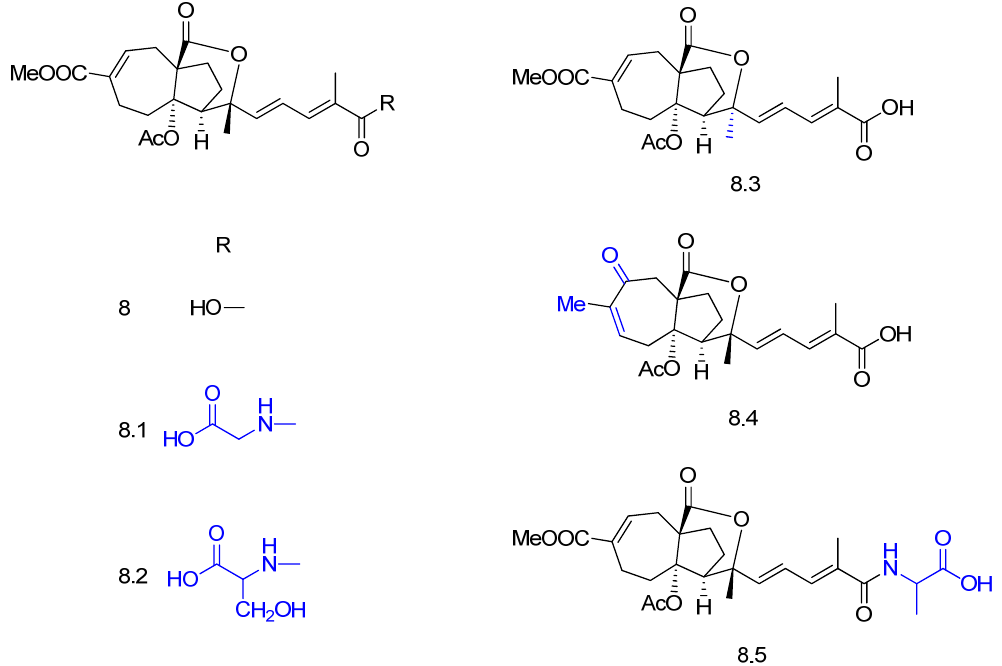
Figure 10. Derivatives ( 8.1 – 8.5 ) of pseudolaric acid ( 8 ) obtained by Chaetomium globosum biotransformation [46].